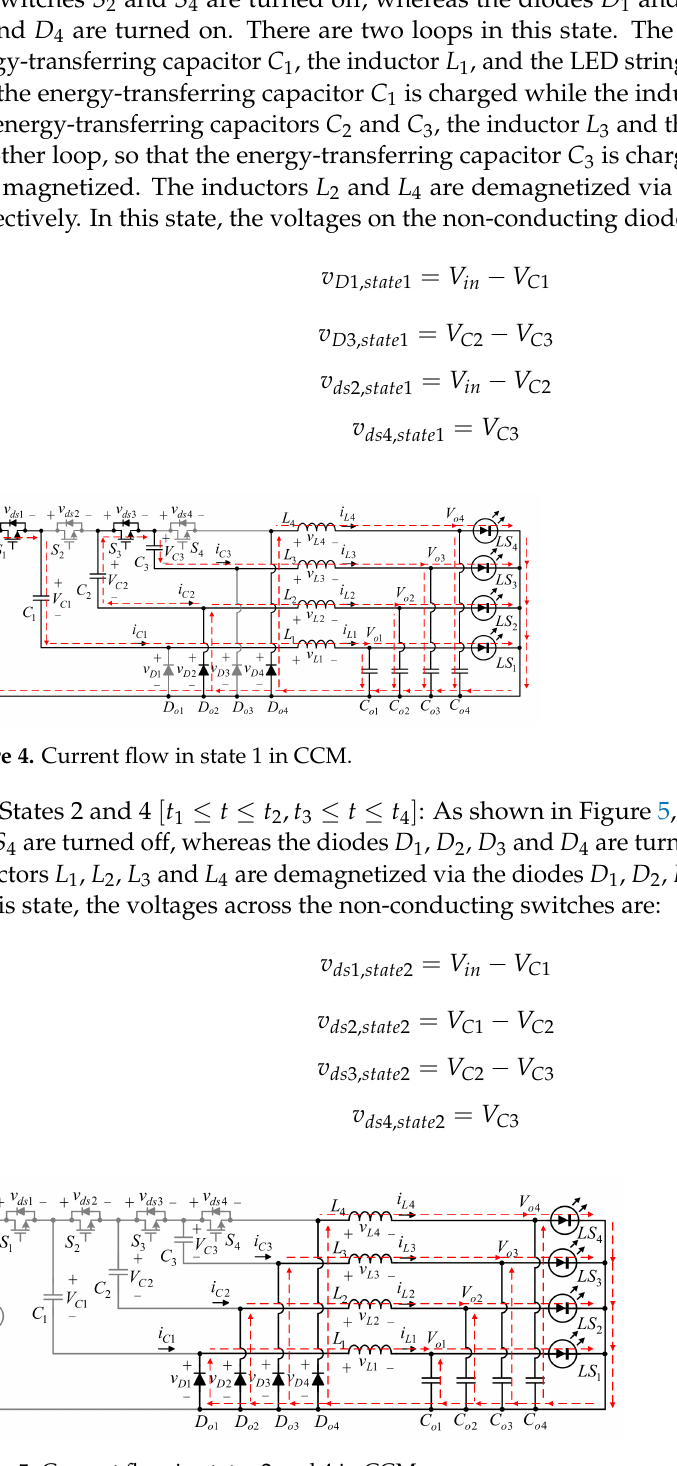
Figure 5. Current flow in states 2 and 4 in